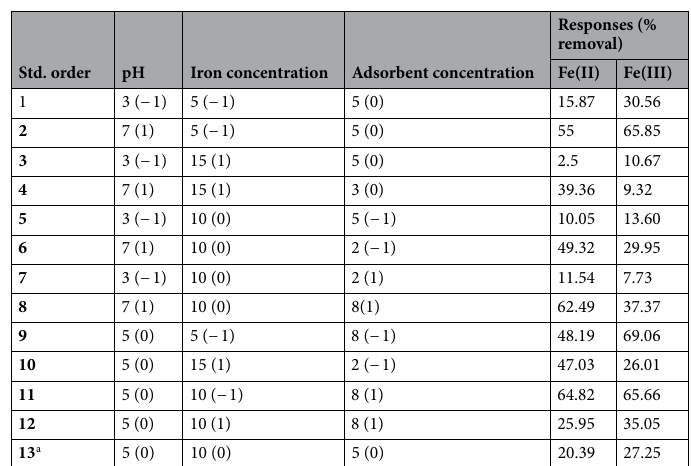
Table 1. Box-Behnken experimental design with coded and un-coded operational variables and the obtained results for the removal of Fe(II) and Fe(III) from aqueous solutions. a Five replicates at the center point.